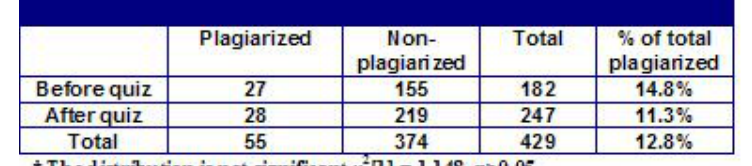
Table 3. Results of Chi-square